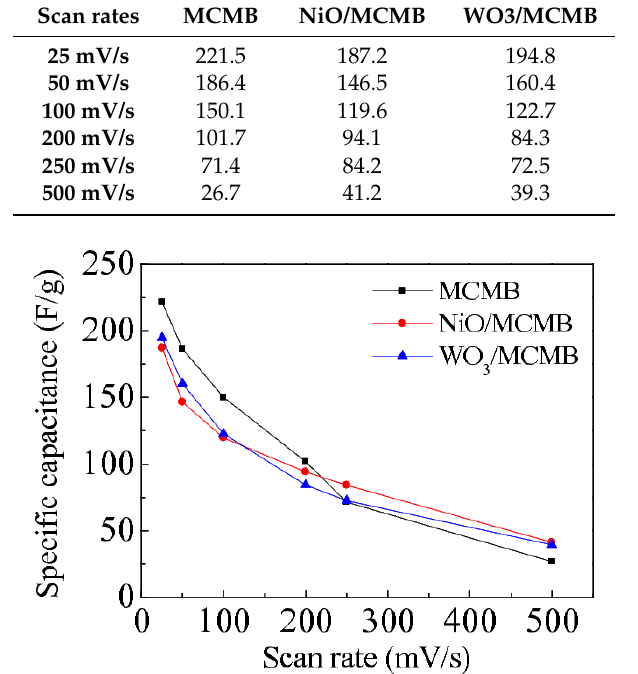
Table 1. The specific capacitance (F·g − 1 ) of the composite electrode at various scan rates.